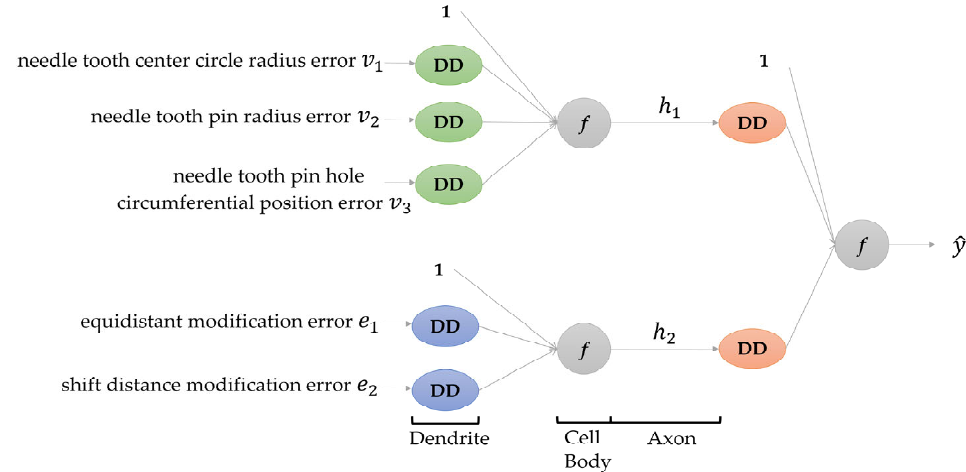
Figure 4. Dendritic neural network (DDNN) model. Figure 2. Dendrite module.